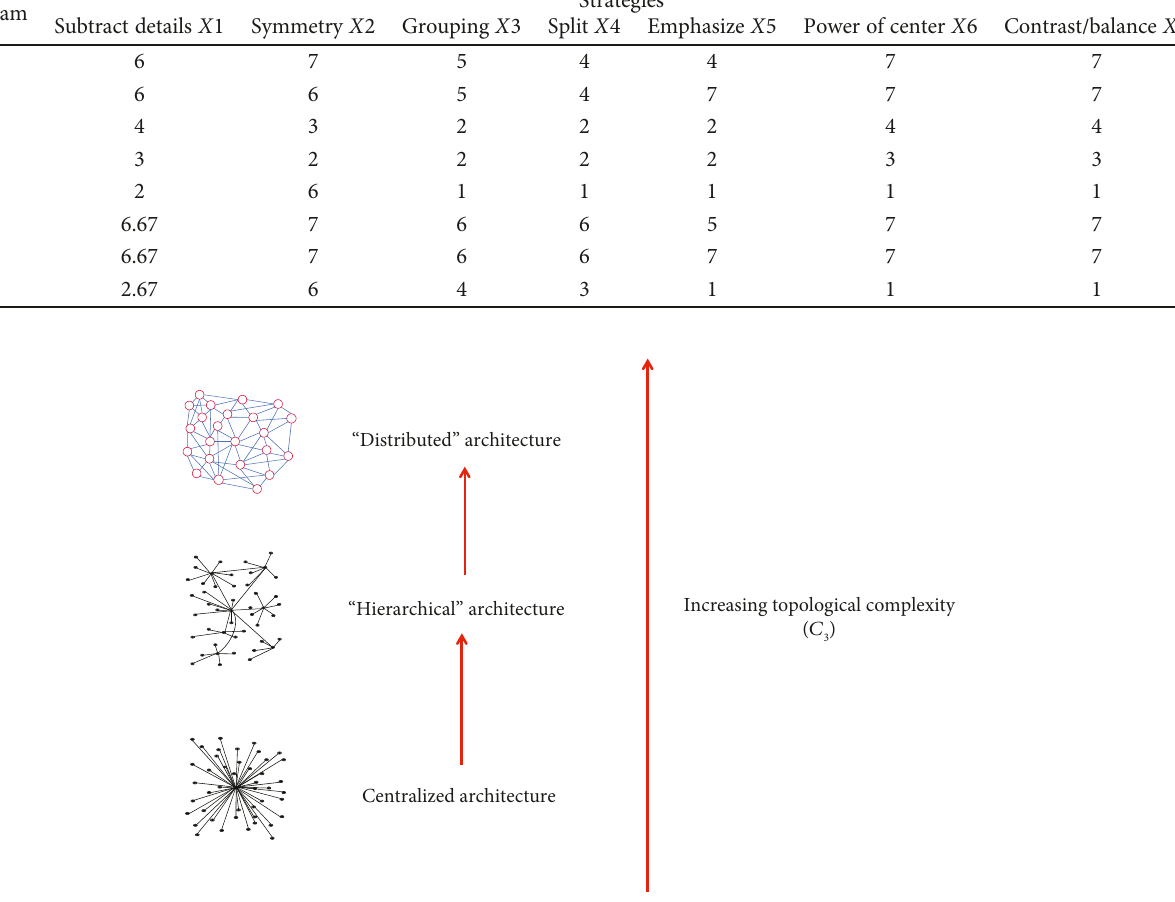
Figure 3: Architectural patterns de fi ned in terms of topological complexity (source: Sinha [24]). Table 3: Average ranking of perceived implementation e ff ectiveness and perceived elegance ( N = 27 ) on a 7-point Likert scale with 1 =most preferred and 7 =least